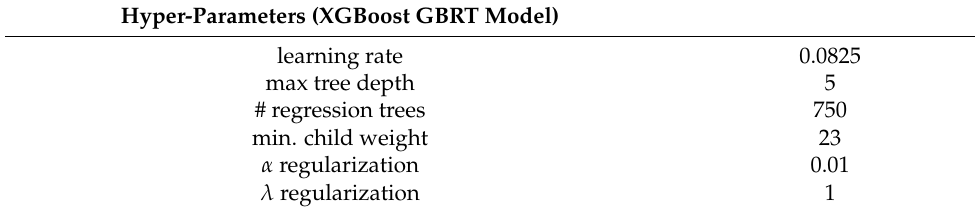
Table 2. Hyper-parameters for the trained GBRT model. See xgboost parameters in sci-kit learn (https://xgboost.readthedocs.io/en/latest/parameter.html accessed on 5 April 2021) for explanation of these